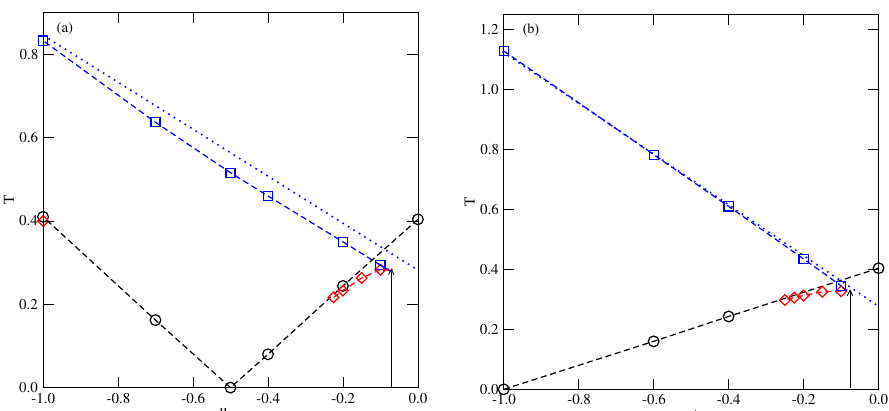
Figure 5. The changes of the critical temperature (squares), the temperature of the orientational order–disorder transition at ρ = 1.0 (circles) and the triple point temperature (diamonds) versus u AB for the systems with u BB = 0 ( a ) and versus u ∗ ( b ). The dotted lines mark the predicted changes of the critical temperature in the systems with isotropic